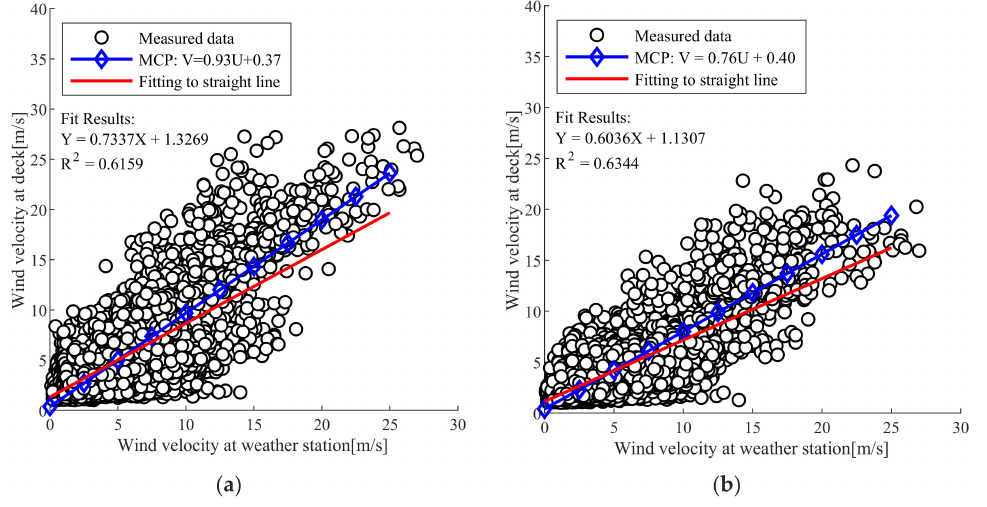
Figure 2. MCP correction of wind velocity; ( a ) At pylon; ( b ) At deck.